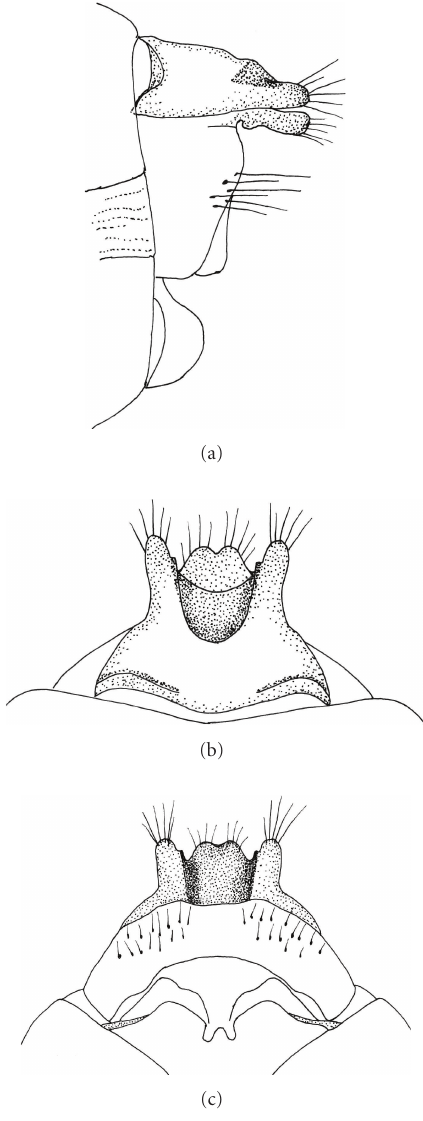
Figure 5: Chaetopteryx bektasensis Sipahiler, female genitalia: (a) lateral; (b) dorsal; (c)